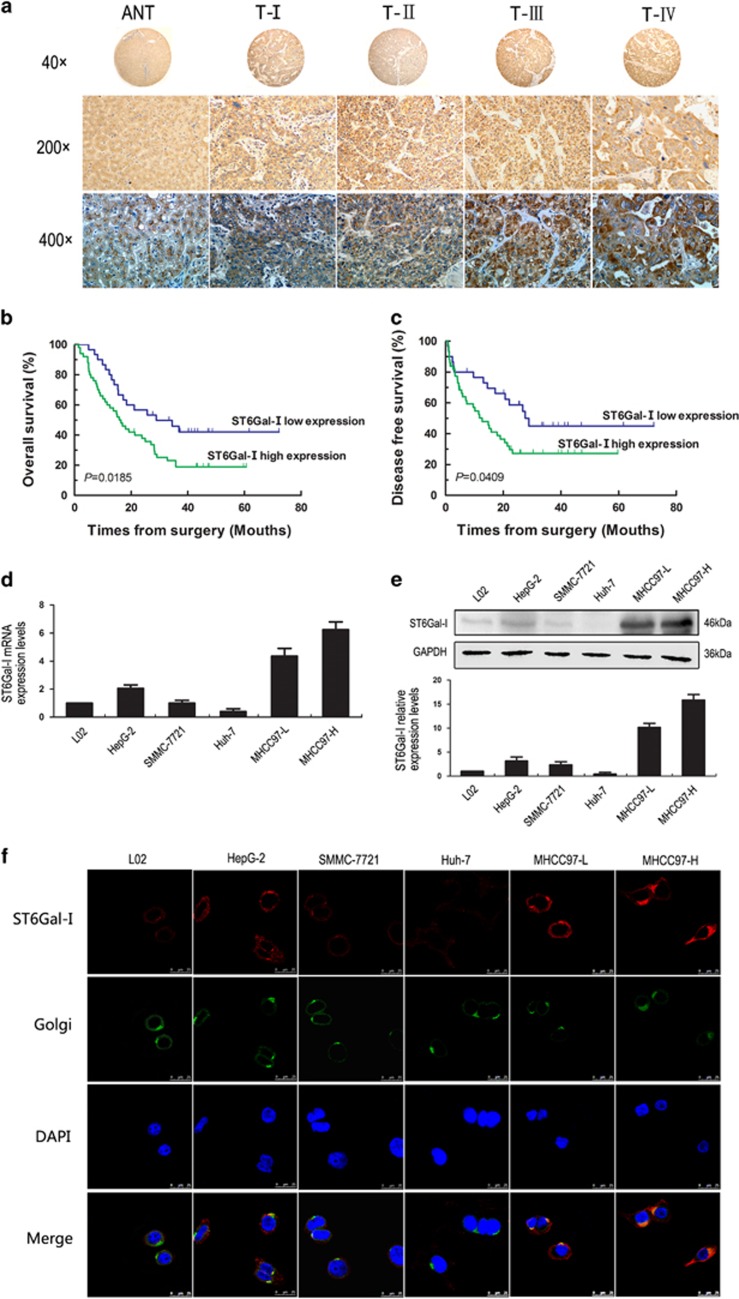
ST6Gal-I is highly expressed in HCC cells and tumor tissues. (a) IHC analysis of ST6Gal-I expression in adjacent noncancerous tissues (ANT) and different grades of HCC tissues (n=80). (b, c) HCC patients with higher expression of ST6Gal-I show worse overall (b, c) disease-free survival. (d, e) q-PCR and western blot assays were analyzed for the expression of ST6Gal-I in HCC cell lines and normal human hepatocyte cells. *P<0.05. (f) Immunofluorescence data verifying the location of ST6Gal-I in HCC cell lines and normal human hepatocyte cells. Original magnification was × 40.